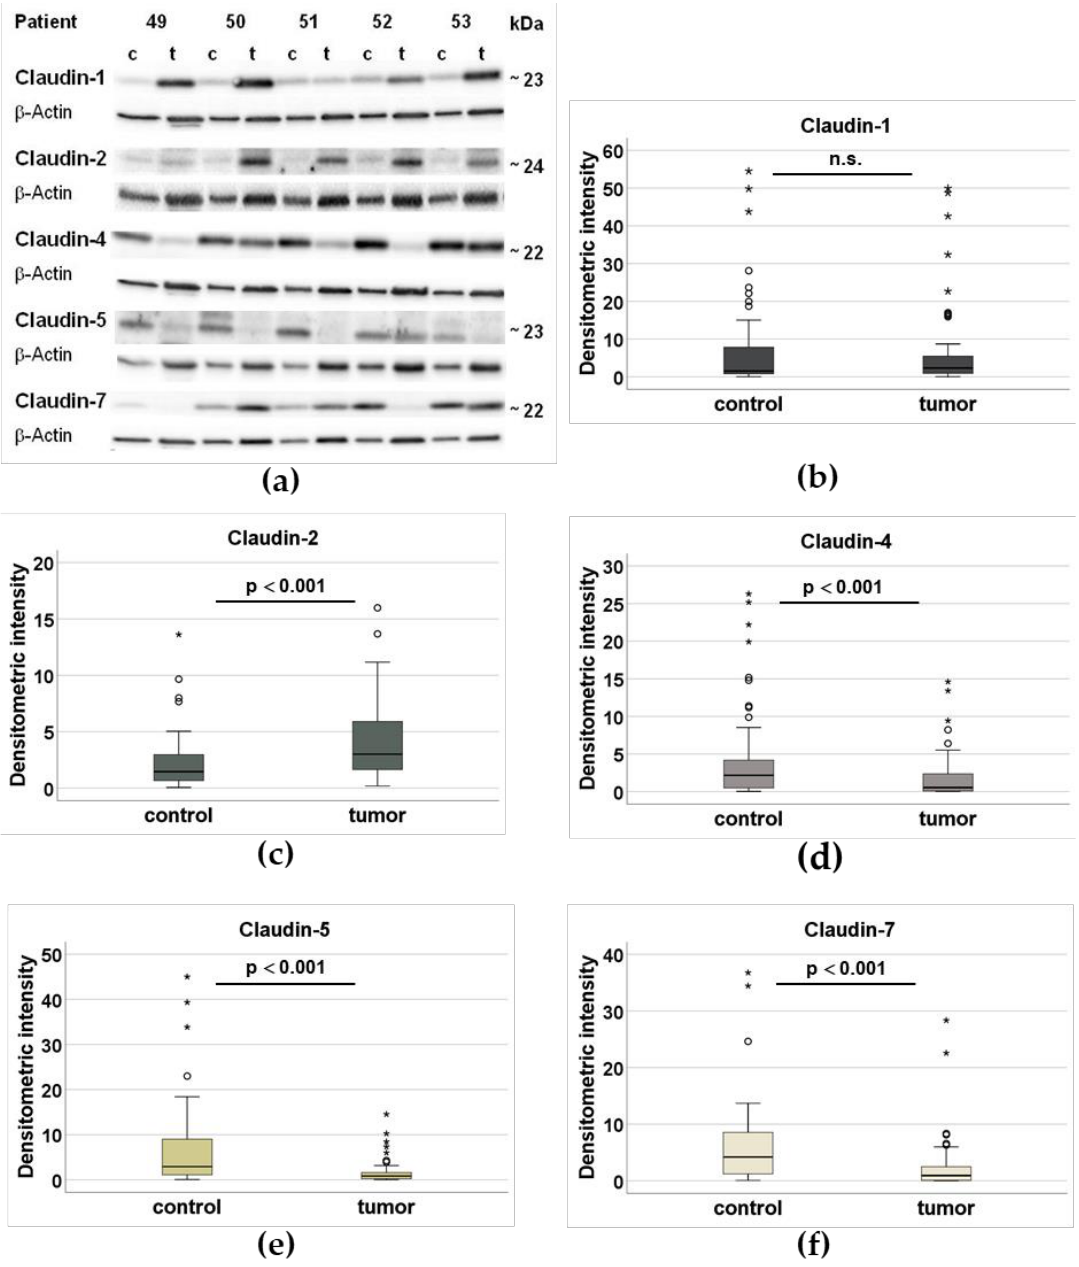
Figure 1. Analysis of claudin expression using Western blots. ( a ) Western blot analysis of the claudins in the control tissue (c) and the respective tumor tissue (t) of patients 49–53, normalized by the loading control ß-actin (42 kDa). The intra-individual comparison between the tumor and the control is carried out on the basis of the intensity of the bands. ( b – f ) In box plots, densitometric analyses of the expression of claudin-1, claudin-2, claudin-4, claudin-5, and claudin-7 in the healthy control tissue of the 60 patients (n = 60) and the tumor tissue (n = 60), normalized and represented with the loading control β -actin ( ◦ outlier, * extremal value, significantly different from control p < 0.001, n.s. not